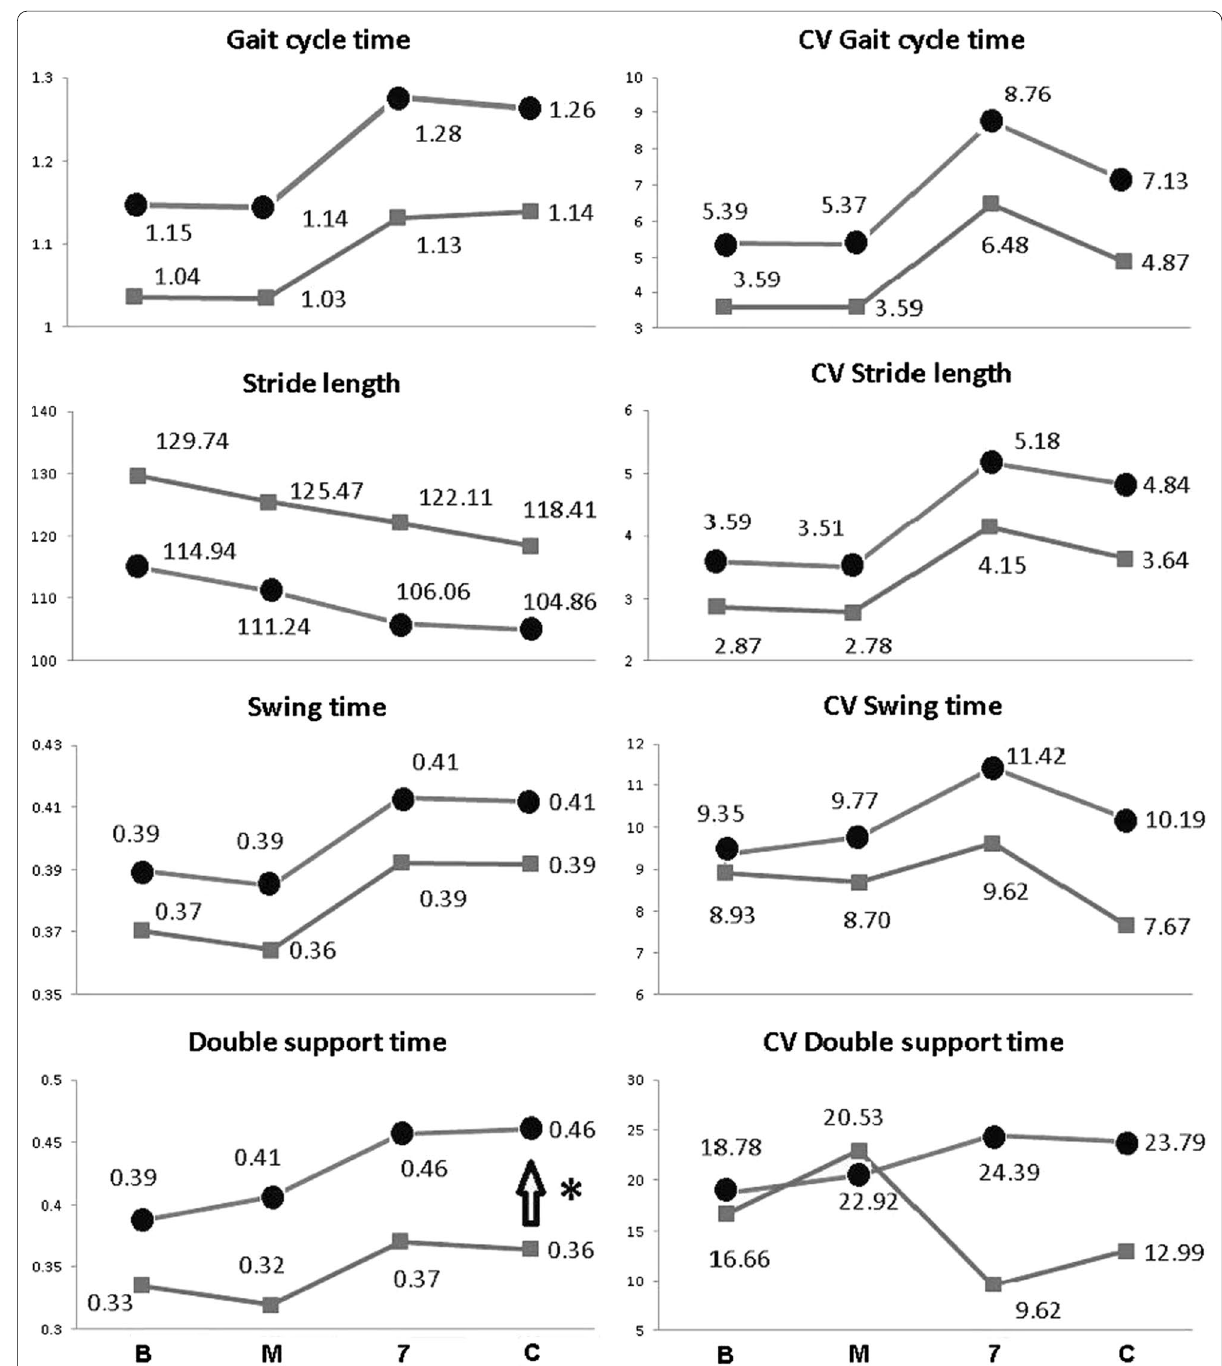
Fig. 1 Comparison between FM patients (circle) and control subjects (square). Four left panels represent FM cycle time, stride length, swing time and double support time compared to controls, while four right panels represent the CV’s of cycle time, stride length, swing time and double support time. Patients and controls performing the following tasks: base walk (B), motor task (M), cognitive task (7) and combined motor and cognitive tasks (C). Each symbol represents the mean values. Note panel Double support time—*represents significance (Mann Whithey U test, p =